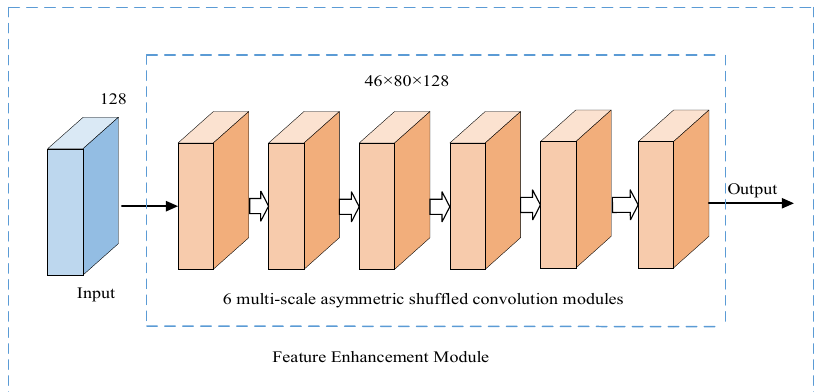
Figure 3. Feature enhancement module.